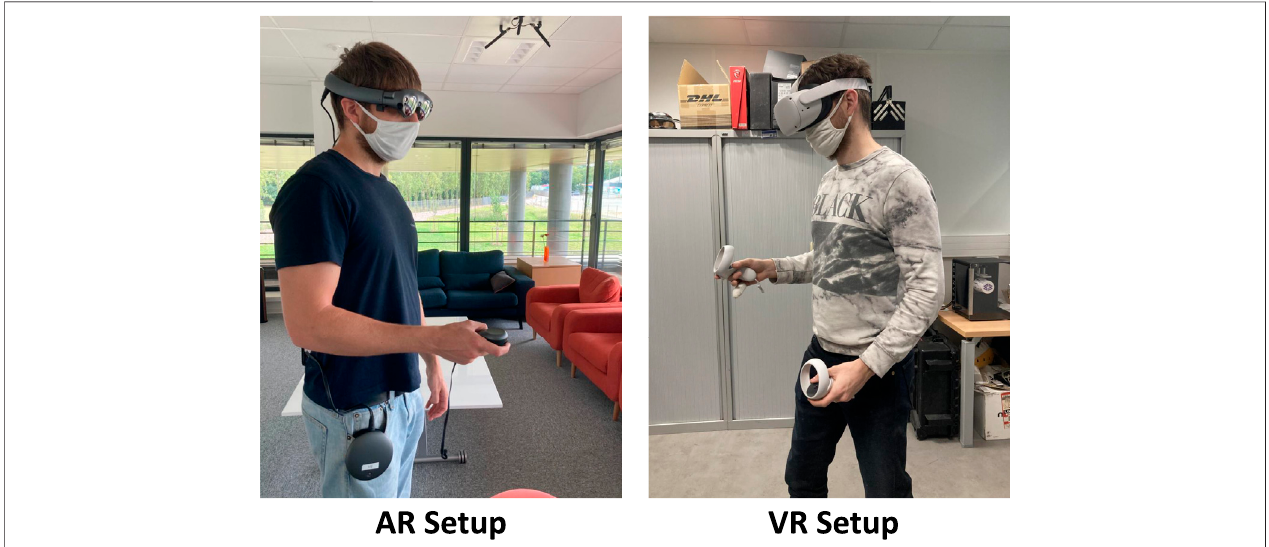
FIGURE 3 | In the AR setup we used the Magic Leap one headset composed of a semi-transparent display, a 6DoF controller and computing unit attached to the pocketoftheuser.IntheVRsetupweusedanOculusQuesttwoconnectedtoaPCwiththeexperimentalAir-Linkmode.Theheadsetcomeswithtwo6DoFcontrollers.